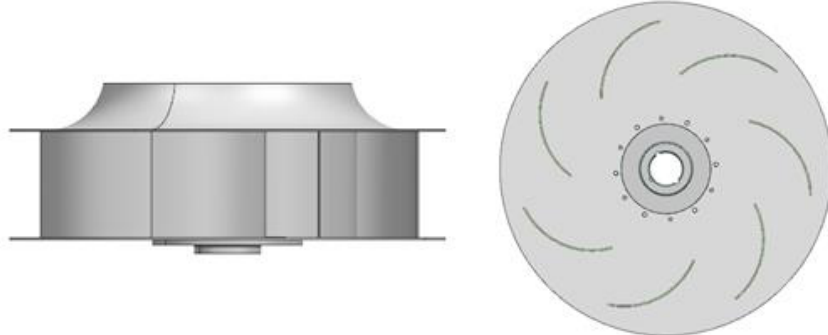
Figure 1. Geometric shape of the original model (PRL-560L0). Table 1. Rated variables of the plenum fan.